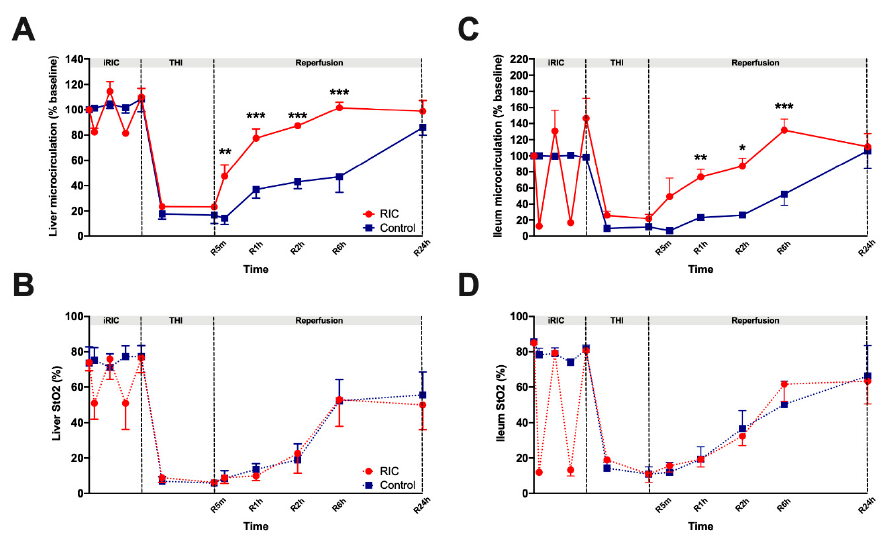
Figure 2. Microcirculation of the ileum and the liver. ( A ) Liver perfusion measured with the O2C device remained higher in the RIC group compared to Control throughout the reperfusion period. ( C ) Ileum perfusion remained higher in the RIC group compared to Control throughout the reperfusion period, however the significant difference between the two experimental groups has disappeared after 24-h of reperfusion. ( B , D ) Partially similar characteristic features were observed in terms of tissue oxygen saturation of the liver and ileum over the course of the observation period, however, StO 2 values did not follow directly the positive alterations of the flow observed in the RIC group. Accordingly, no significant between group differences were detected. (mean ± s.e.m, * p < 0.05, ** p < 0.01, *** p < 0.001, RIC vs. Control, two-way ANOVA and Bonferroni post-hoc test, n = 5/group/time point). Baseline was determined as the mean flow measured in 10 healthy animals right after laparotomy. Abbreviations used: iRIC—Intestinal remote ischemic conditioning; THI—Total hepatic ischemia, StO 2 —Oxygen saturation.